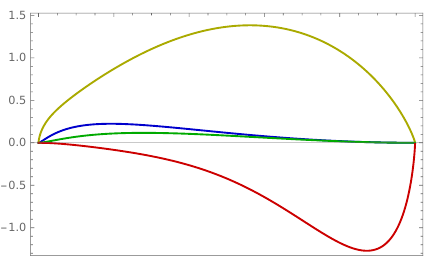
( 0 ) ( 0 ) ( 0 ) , I and I are presented in 1 2 3 ( 1 ) 10 − 1 is shown in 0